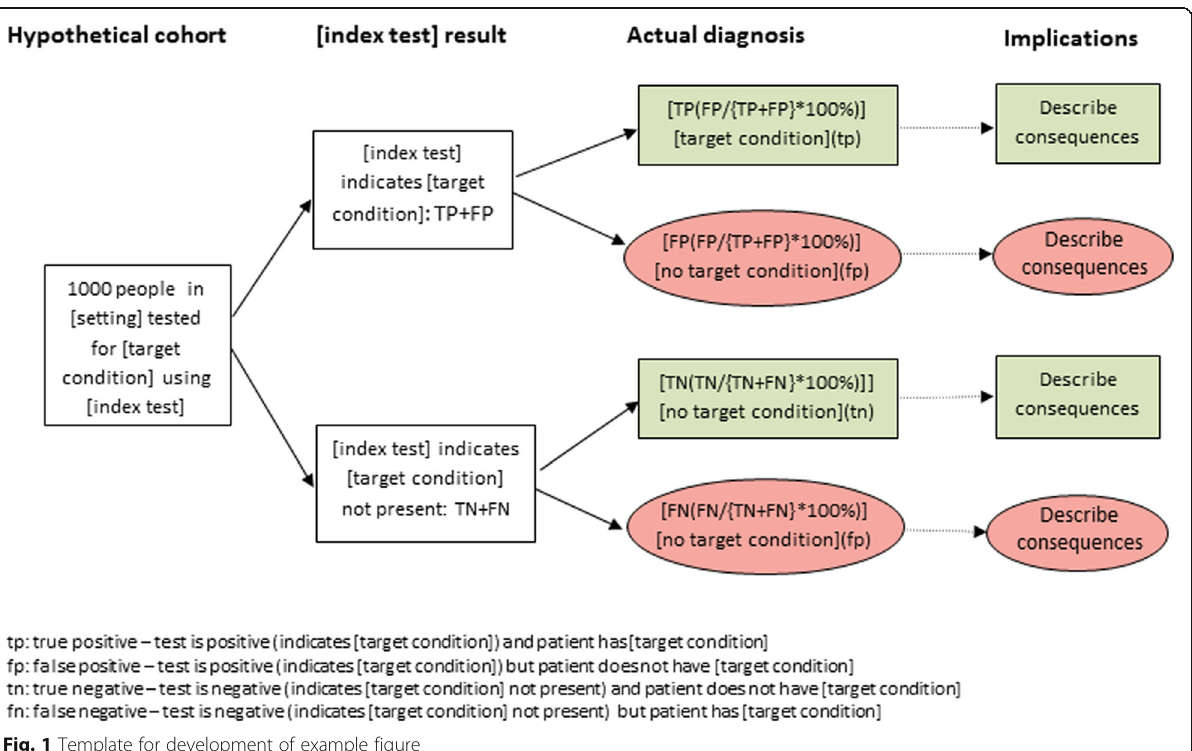
Fig. 1 Template for development of example figure